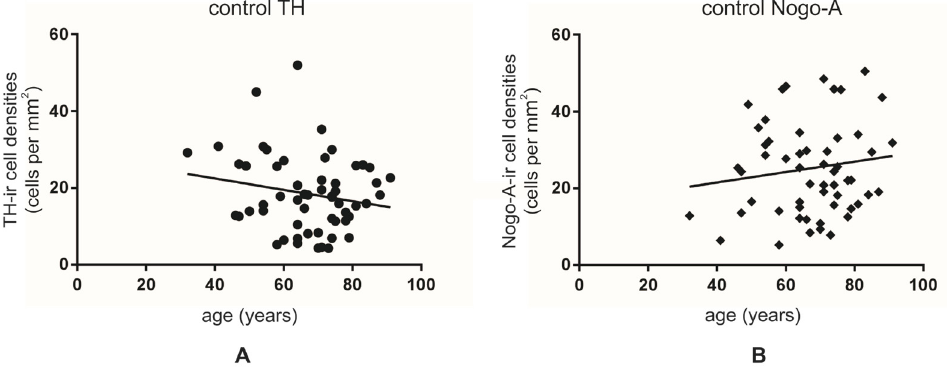
Figure 4. Analysis of TH-ir ( A ) and Nogo-A-ir cell densities ( B ) per mm 2 depending on the age in the human SNc from non-diseased individuals. Both markers did not display a significant association with age.